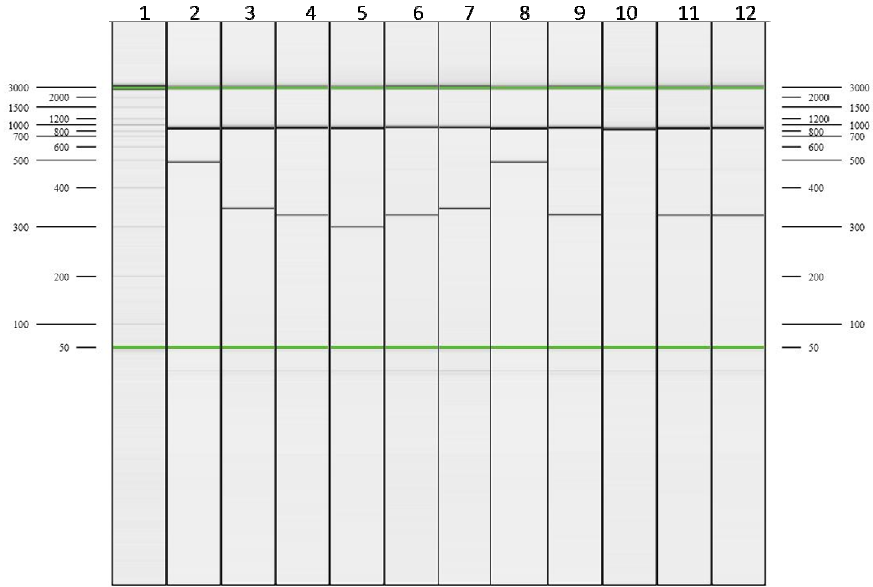
Figure 3. Capillary electrophoresis (CE) electropherogram for multiplex ARMS-A of β globin gene cluster. Lanes 2–5 are the positive controls for 41/41 ( − TTCT), IVS 1-5 (G > C), Cd 26 (G > A), and Cd 17 (A > T) respectively. Lanes 6, 9, 11, and 12 show Cd 26 (G > A); Lane 10 shows “none of the mutations tested present”; and Lanes 7 and 8 show the presence of IVS 1-5 (G >